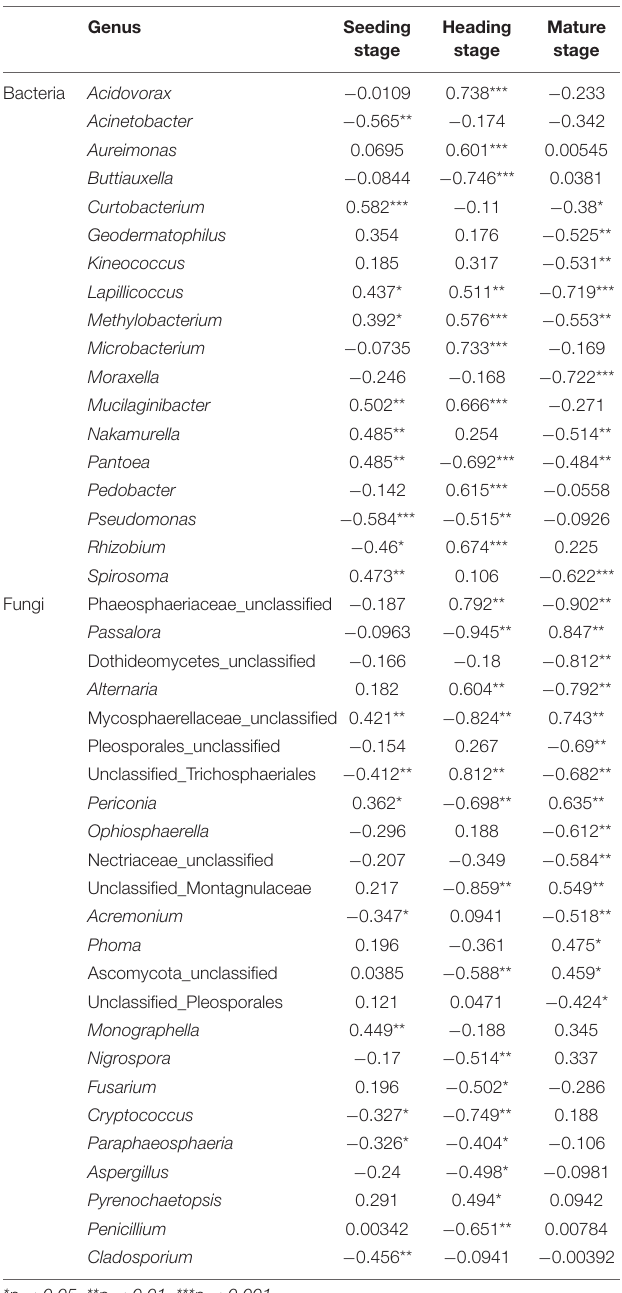
TABLE 1 | The Spearman correlation analysis between top 30 rice phyllosphere bacterial and fungal populations and elevation.